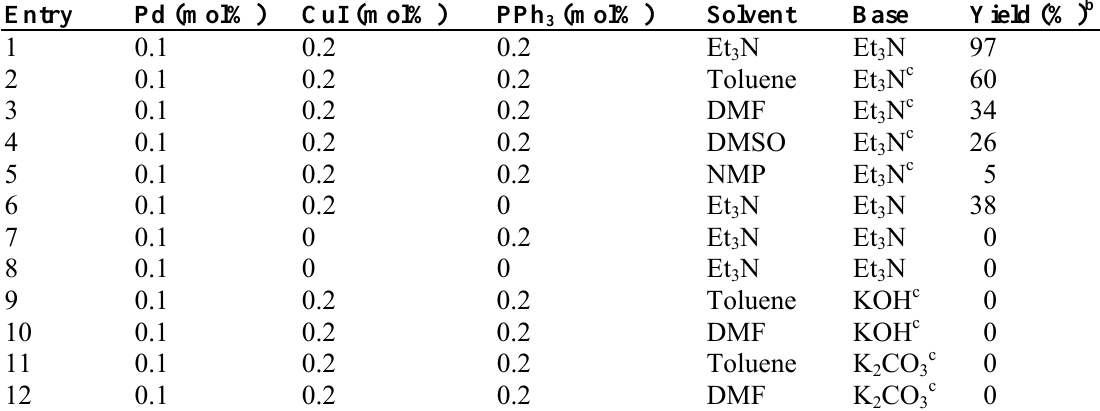
Table 1. NS-MCM-41-Pd-catalyzed Sonogashira coupling reaction of iodobenzene 1a with phenylacetylene 2a .